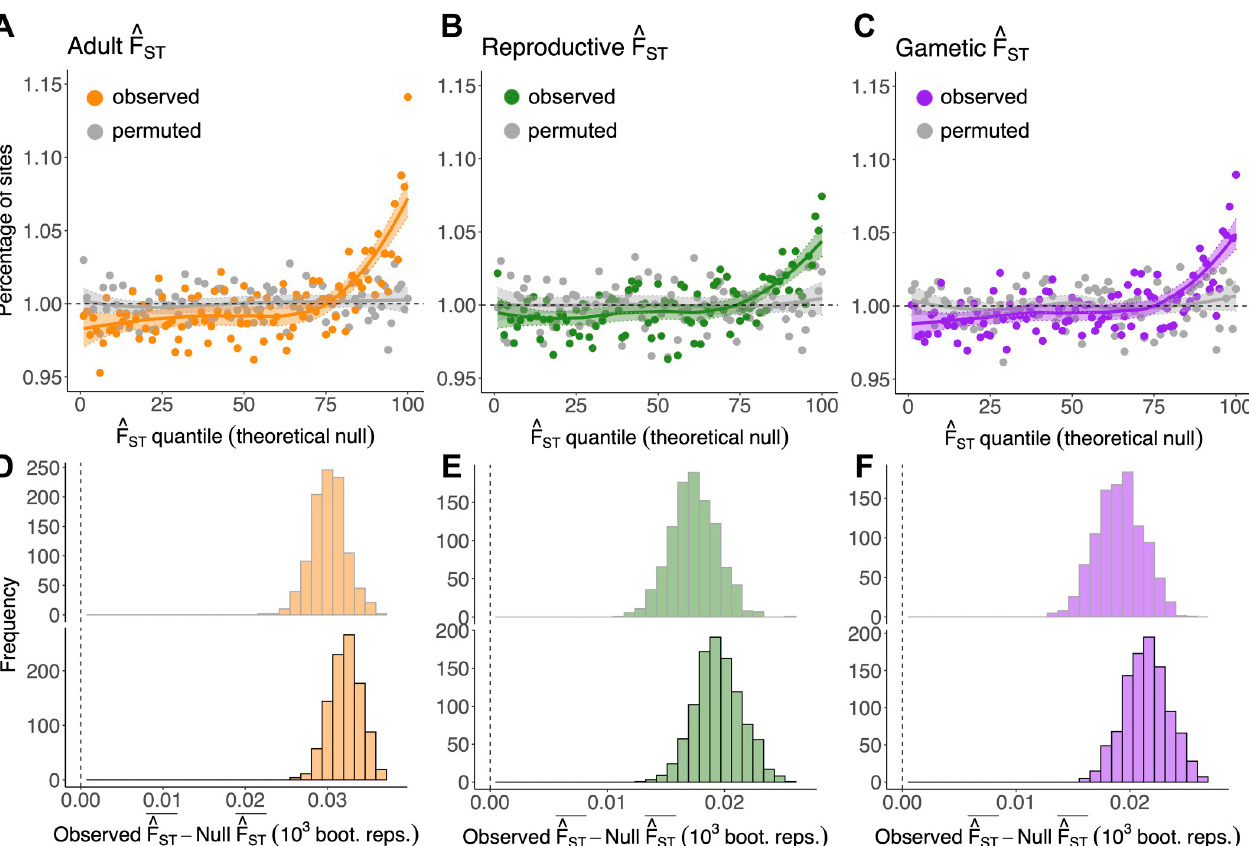
Fig 2. Polygenic signals of sex-differential selection: Inflation in ^ F metrics relative to their nulls. ( A–C ) Percentage of sites (coloured, observed; grey, ST permuted) falling into each of 100 quantiles of the theoretical null distributions of adult ^ F (A), reproductive ^ F (B), and gametic ^ F (C). Theoretical null ST ST ST data ( x -axes) were generated by simulating values (nSNPs = 1,051,949) from a chi-square distribution with 1 degree of freedom. For each locus, observed and permuted ^ F values were scaled by the multiplier of the relevant theoretical null distributions (i.e., the multiplier in Eqs [3A–3C] for adult, reproductive, and ST , respectively; see Materials and methods). In the absence of sex differences in selection, approximately 1% of observed SNPs should fall into each gametic ^ F ST quantile of the null (dashed line). LOESS curves ( ± SE) are presented for visual emphasis. ( D–F ) Difference between the mean of observed and empirical null data for each metric (i.e., adult, reproductive, and gametic ^ F , respectively) (top), and the difference between observed and theoretical null data (bottom), ST across 1,000 bootstrap replicates. Vertical line intersects zero (no difference between observed and null data). As in panels (A–C), ^ F values were scaled by the ST relevant theoretical null distributions. The code and data needed to generate this figure can be found at https://github.com/filipluca/polygenic_SA_selection_ in_the_UK_biobank and https://zenodo.org/record/6824671. SNP, single-nucleotide polymorphism.